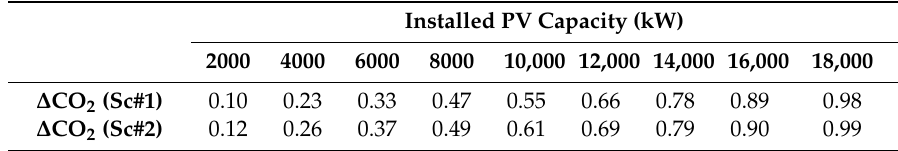
Table 1. Avoided carbon dioxide emissions index in Sc#1 and Sc#2 as a function of installed PV.